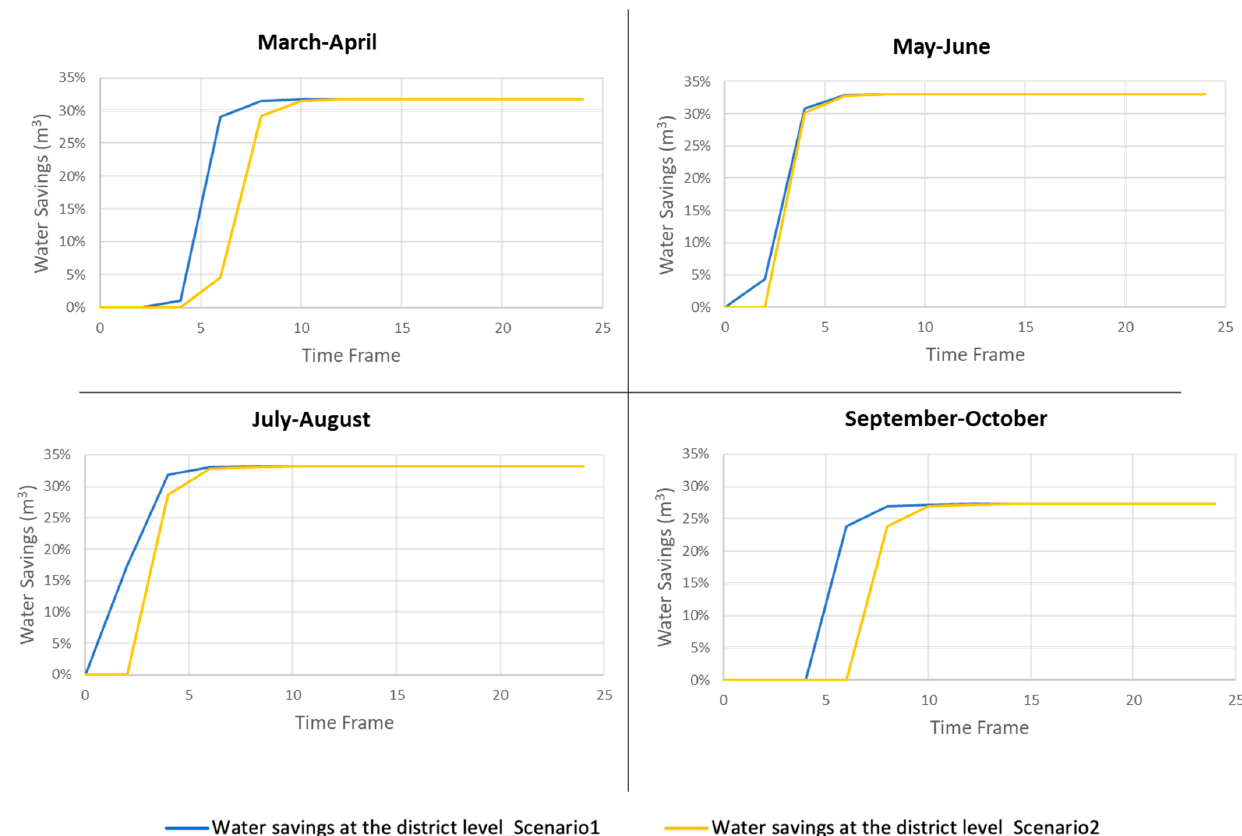
Figure 10. Water savings with the passing of